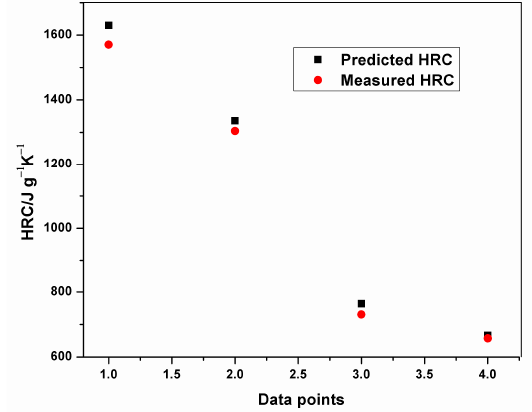
Figure 7. Surface plot of output (HRC), input2 (sample mass) and input1 (heating rate).